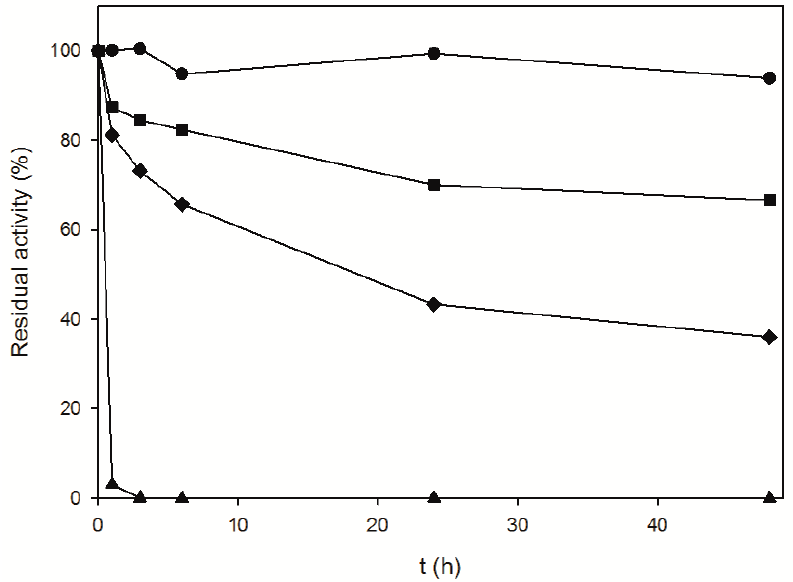
Figure 3. Stability in presence of 20% DMF of free Bp NDT (  ), immobilized Bp NDT on PEI-agarose (  ), immobilized Bp NDT on PEI-agarose followed by cross-linking (1 h) with 50% oxidized aldehyde-dextran (  ), and immobilized Bp NDT on PEI-agarose followed by cross-linking (1 h) with 70% oxidized aldehyde-dextran ( 